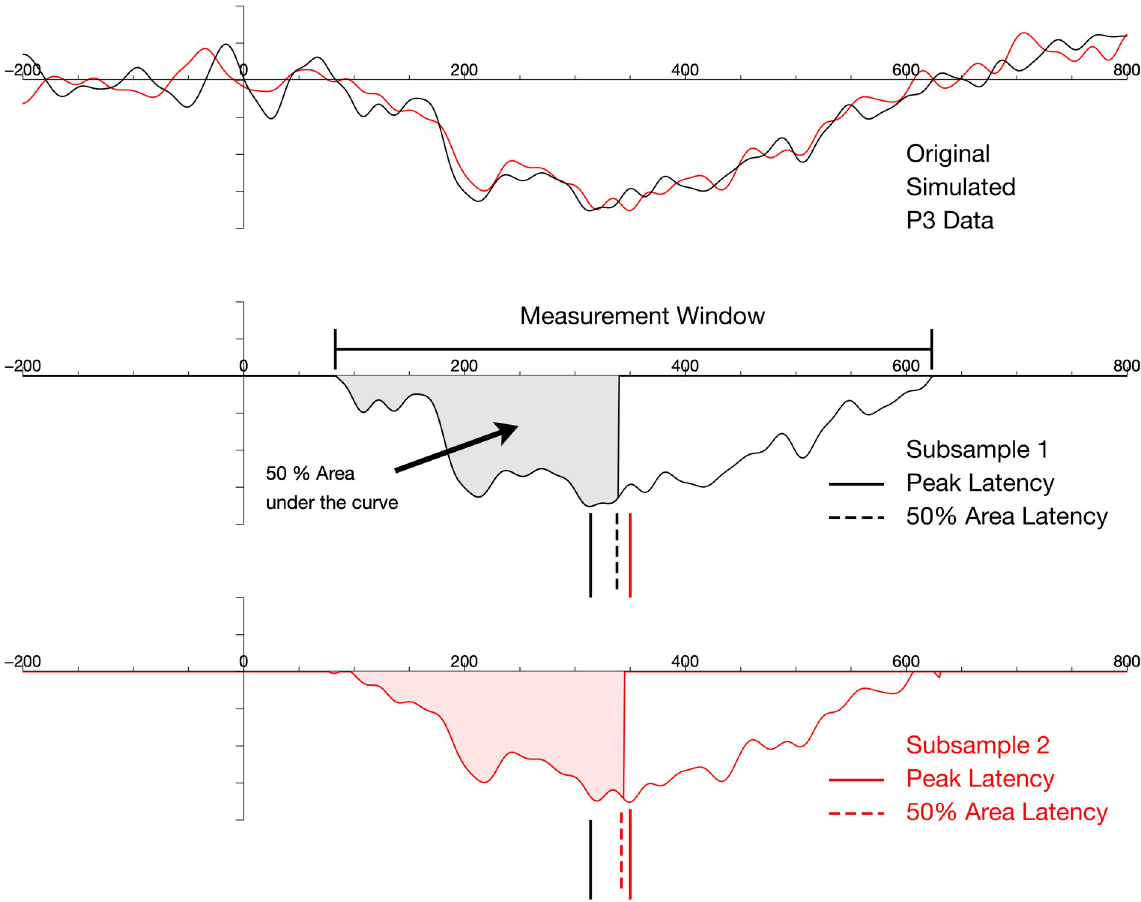
Fig 1. Simulated data for two subsets of a typical posterior waveshape (black and red lines), reflecting a P3 component. Both, peak latencies and 50% fractional area latencies were extracted. Peak latencies denote a single moment of maximal voltage within the designated measurement window. Fractional area latency denotes the moment when the cumulative area under the curve exceeds a defined criterion, here 50% of the overall area. Despite the high similarity of morphology across the two subsets, peak latencies would show an effect of more than 50 ms due to high frequency noise (solid vertical lines), that did not affect fractional area latency to the same amount (dashed vertical lines).